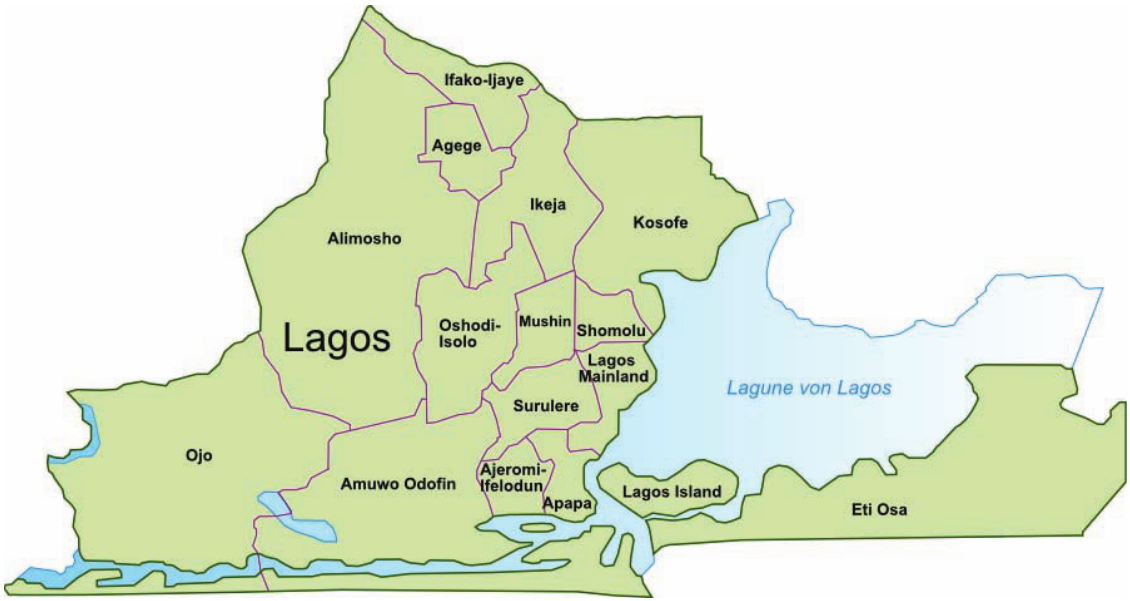
figure 1. Map of lagos metropolis showing the local government areas source: Bohr